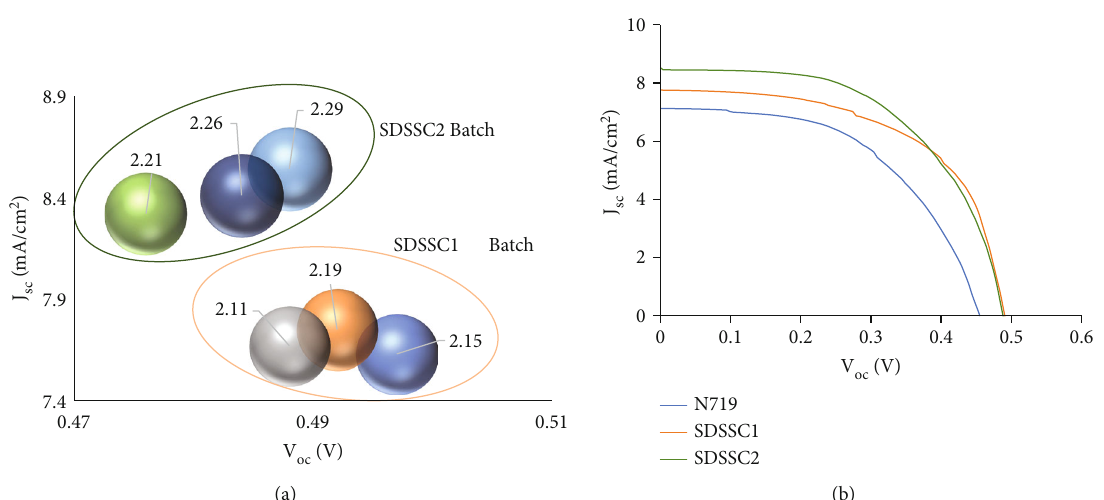
V sc and oc of the SDSSC batches (the diameter of bubbles showed the e